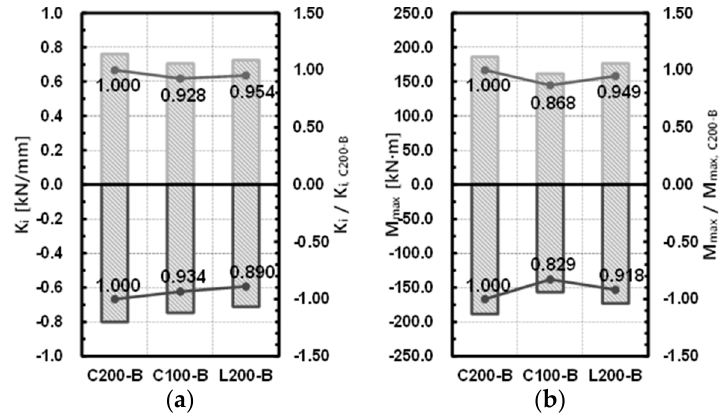
Figure 12. Comparison of a ceiling bracket size and shape. ( a ) Initial stiffness; ( b ) maximum strength.